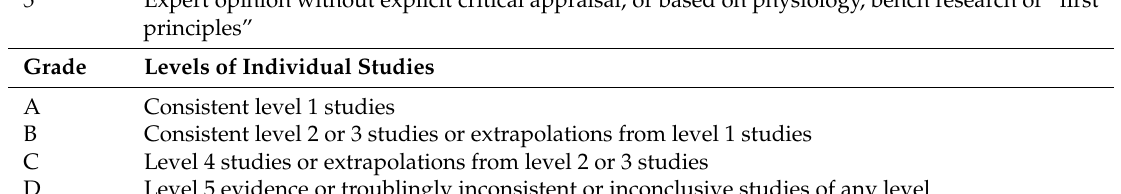
Table adapted from the Oxford Centre for Evidence-Based Medicine [18].